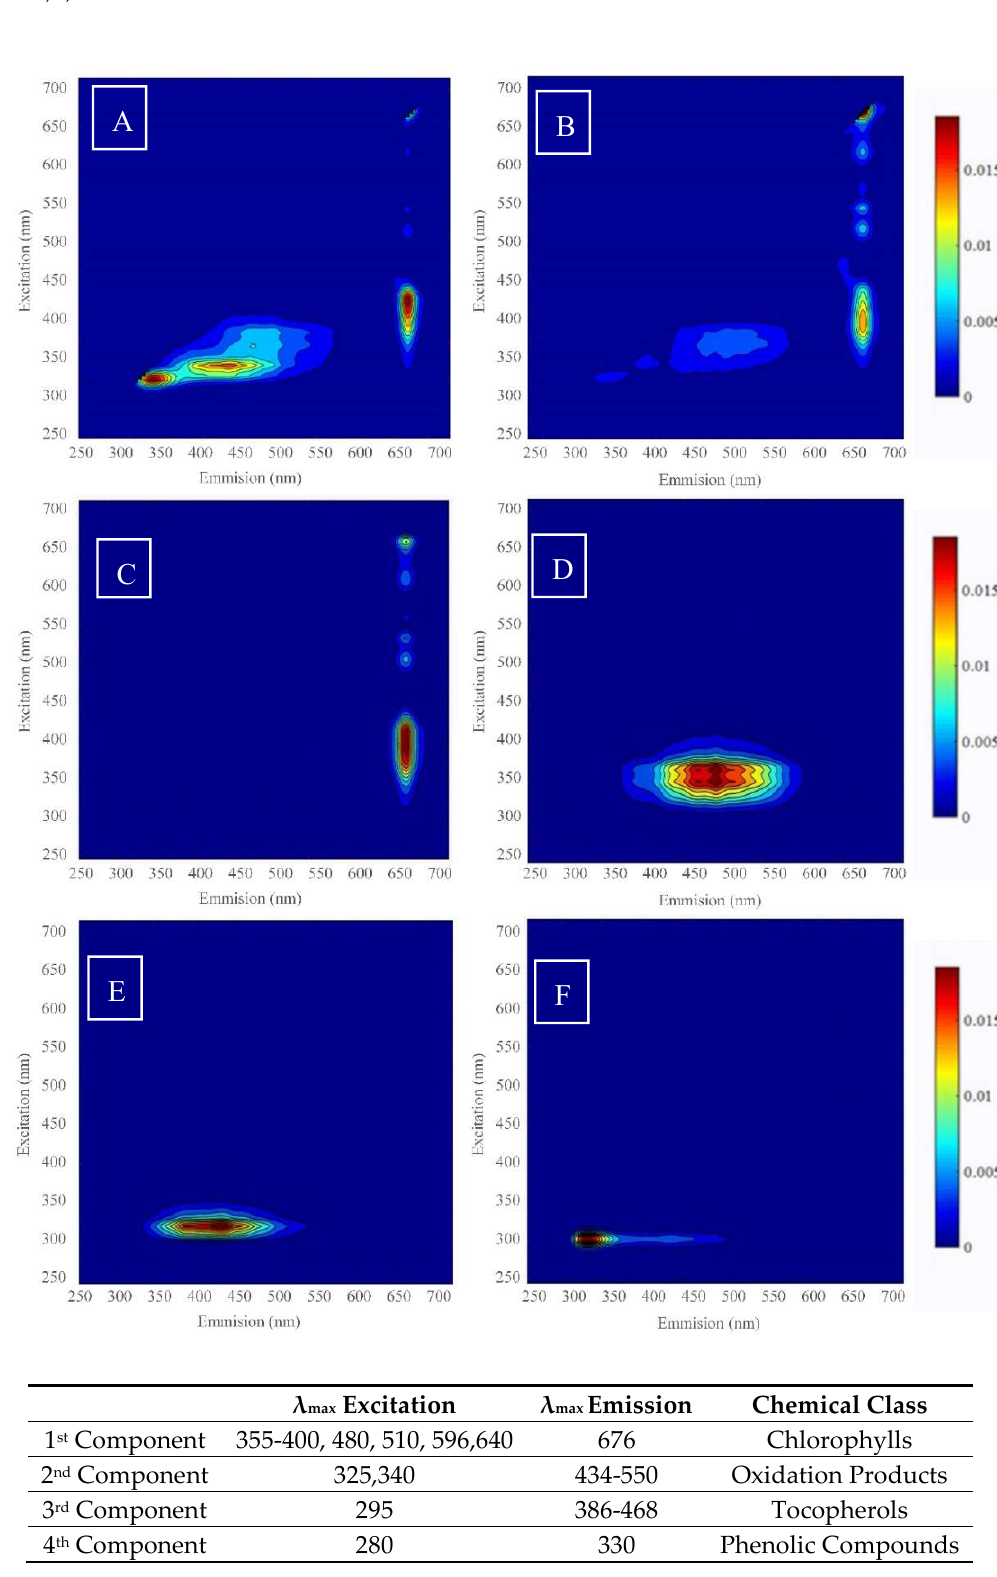
Figure 1. Mode 2 (excitation) and mode 3 (emission) PARAFAC components from four component modes represented as an EEM spectrum. ( A ) EEM of typical Maltese EVOO, ( B ) EEM of typical non-Maltese EVOO, ( C ) Chlorophyll, ( D ) oxidation products, ( E ) tocopherols, ( F ) phenolics.